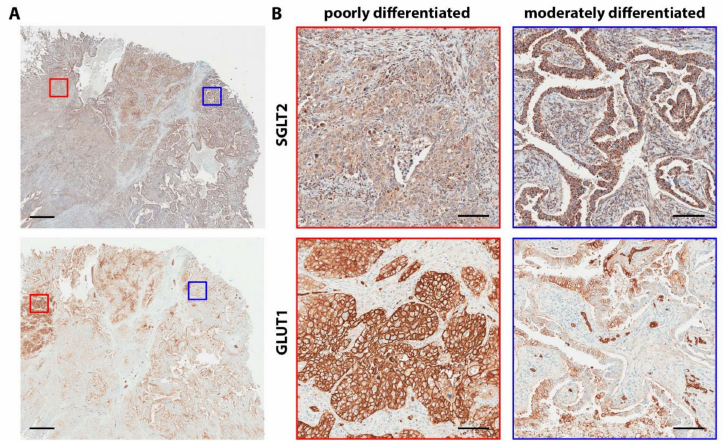
Figure 6. Glucose transport heterogeneity in lung adenocarcinoma. A representative sample of human lung adenocarcinoma was stained with specific antibodies against SGLT2 (upper panels) and GLUT1 (lower panels) in adjacent sections. ( A ) Low magnification showing heterogeneous distribution of the SGLT2 and GLUT1 expression in the tissue. Scalebar, 1 mm; ( B ) Higher magnifications of the areas delimited by the red and blue squares in A. The red square highlights an area of poorly-di ff erentiated GLUT1-positive cancer, the blue square delimits a region of moderately-di ff erentiated SGLT2-positive cancer. Scalebars, 100 µ